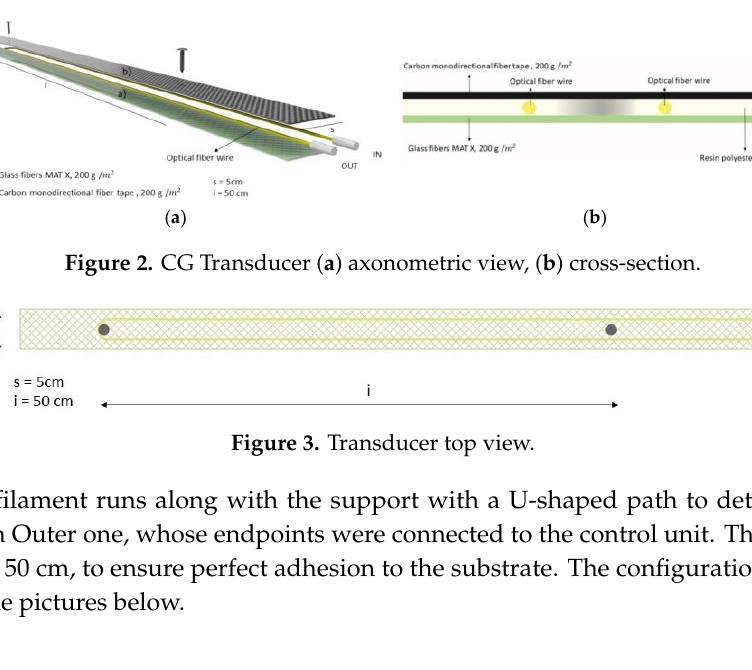
Figure 1. Glass fiber tapes (GG) Transducer ( a ) axonometric view, ( b ) cross-section.